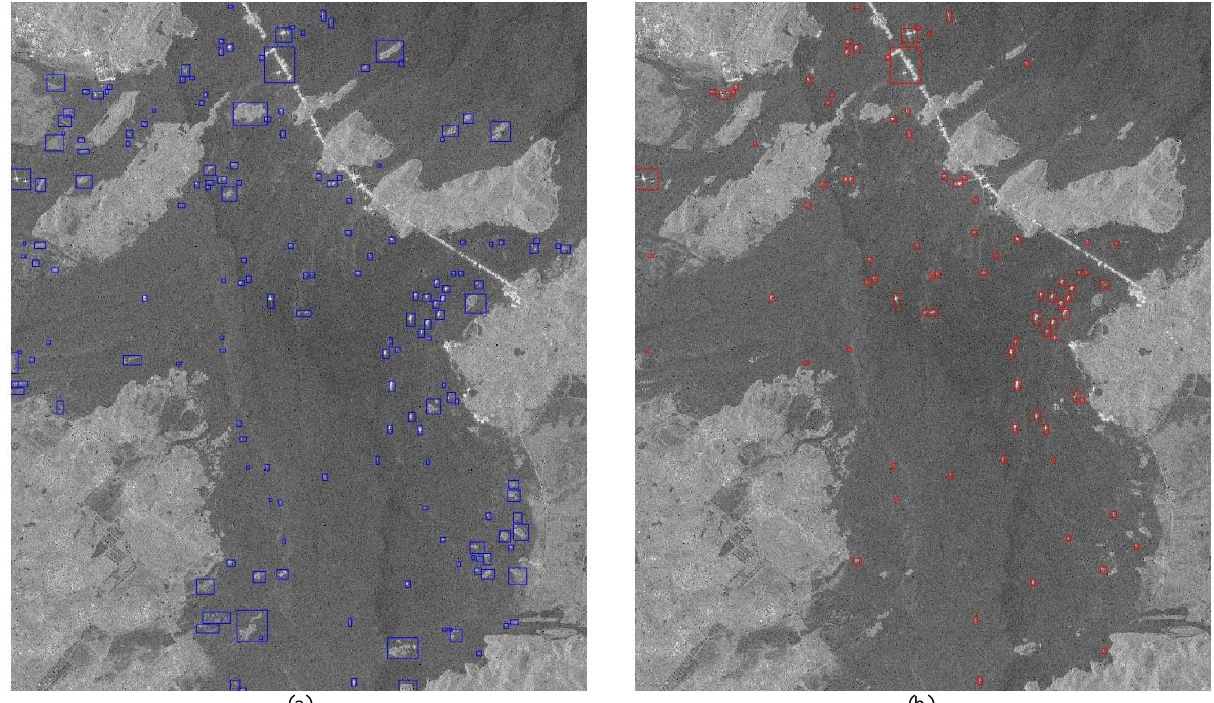
Fig.7 Experimental results. (a)Ship areas proposal results, (b)ship detection